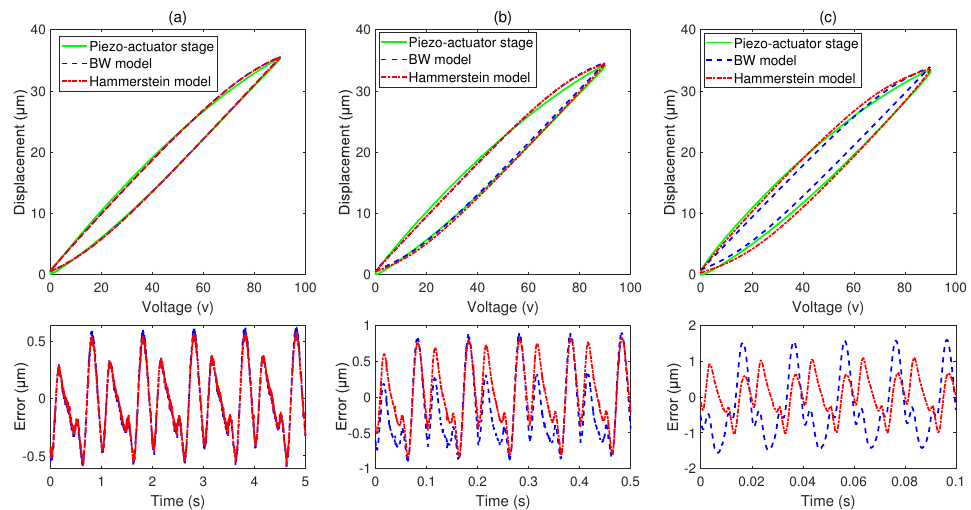
Figure 4. Modeling results of the Hammerstein model in comparison with the BW model under sinusoidal input voltages of different frequencies: ( a ) modeling result at frequency of 1 Hz; ( b ) modeling result at frequency of 10 Hz; ( c ) modeling result at frequency of 50 Hz. Table 1. The MAXAE and MAE of BW model and Hammerstein model. MAXAE of the BW Model/ MAE of the BW Model/